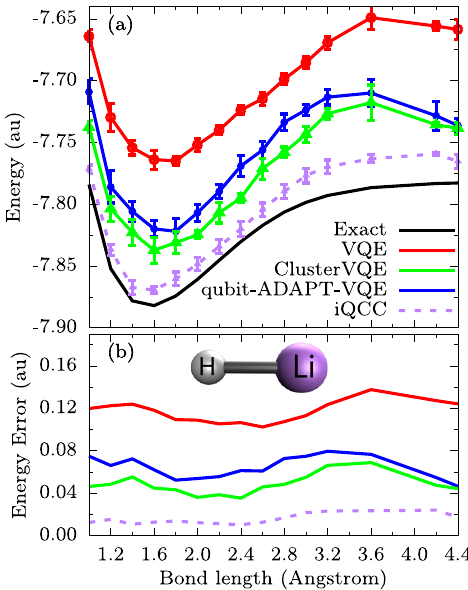
Fig. 5 PES of LiH molecule in the presence of noise. a Dissociation curves of LiH and (b) corresponding errors with exact diagonaliza- tion (black), VQE (red), qubit-ADAPT-VQE (blue), iQCC (purple), and ClusterVQE (green) methods on a noisy simulator. The custom noise in Qiskit 59 was used, where the error rates of single-qubit and two- qubit gates are 0.001 and 0.005, respectively. The means and error bars are calculated from 5 independent simulations.